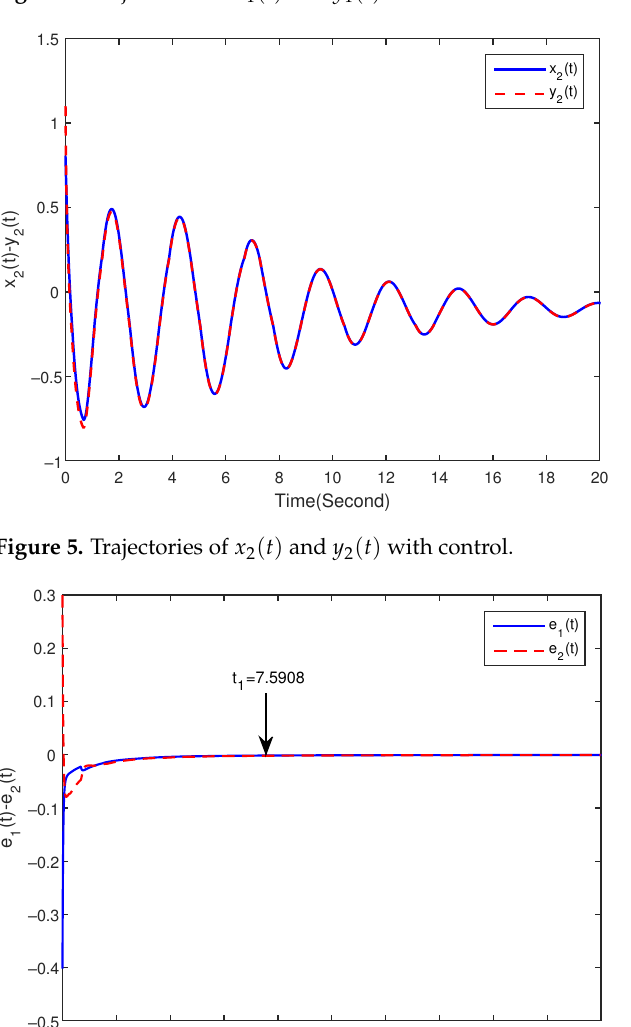
Figure 4. Trajectories of x 1 ( t ) and y 1 ( t ) with control.